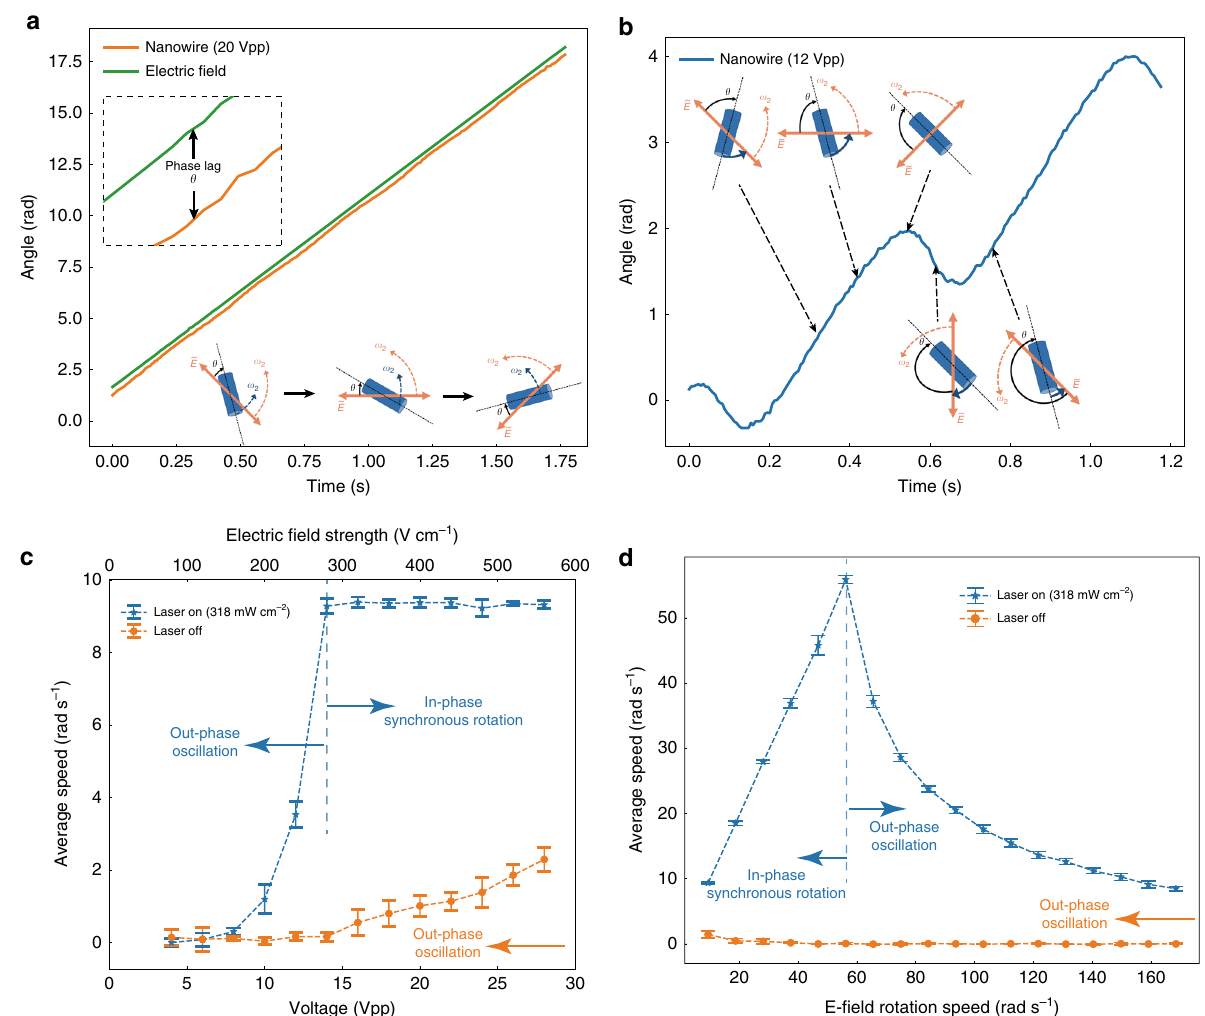
Fig. 4 Light-switchable rotation of a Si nanowire stepper motor. a , b Rotation angle versus time of a nanowire at different voltages (or electric fi eld strengths) exposed to 318 mW cm − 2 532-nm laser. a The E- fi eld rotates at 1.49 Hz (in green). The stepper motor rotates synchronously with the E- fi eld with a phase lag θ , at 20 Vpp (400V cm − 1 ) (in orange). Inset: the constant phase lag between the driving E- fi eld and the rotating nanowire. b It switches to the out-phase oscillation mode at 12 Vpp (240 V cm − 1 ) (more details in Supplementary Note 7 and Supplementary Figs. 3, 4). Schematics show the relative positions of a rotating nanowire with the E- fi eld at different time. c Average rotation speed of a micromotor versus driving voltage/electric fi eld strength with (in blue) and without laser illumination (in orange). The driving E- fi eld is 1.49 Hz, same as that the in-phase rotation of the nanowire (see Supplementary Movies 4, 5 for the curve in blue). d Average rotation speed of a micromotor versus rotation speed of the driving E- fi eld at 30 Vpp (600 V cm − 1 ) with (in blue) and without laser illumination (in orange) (see Supplementary Movies 6, 7 for the curve in